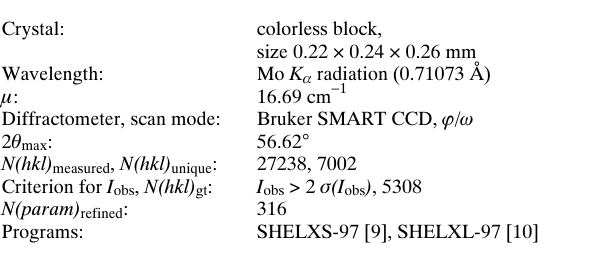
Table 1. Data collection and